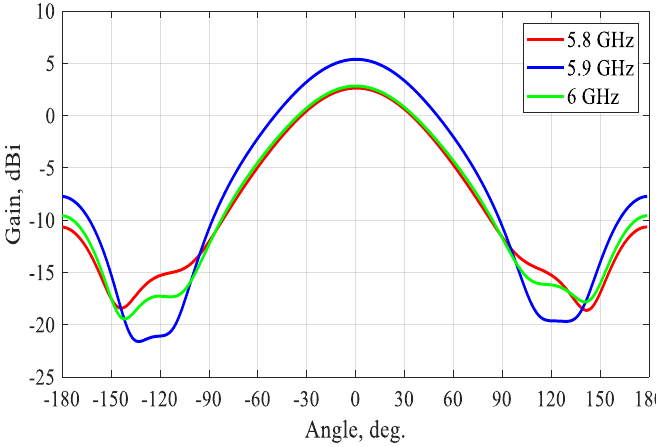
Figure 5. The unit-cell radiation pattern for 5.8 GHz, 5.9 GHz, and 6GHz.